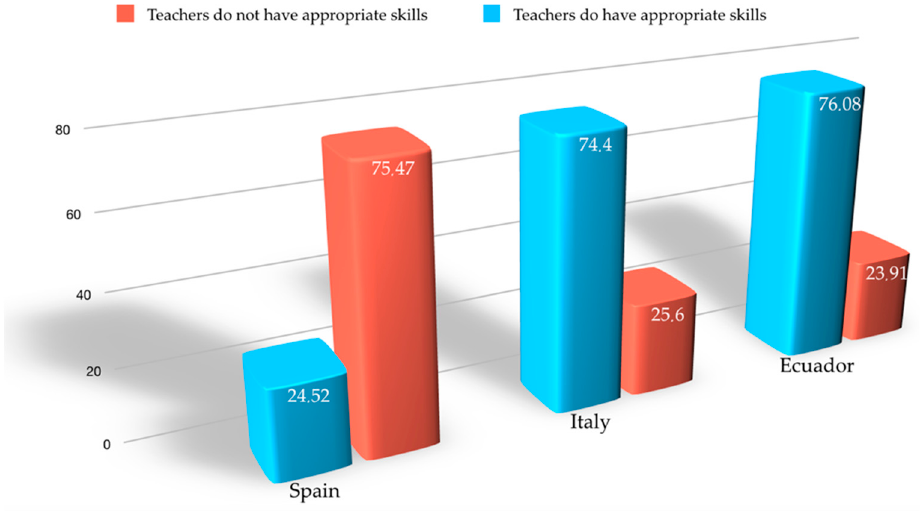
Figure 4. Students’ perception about classes during the lockdown.